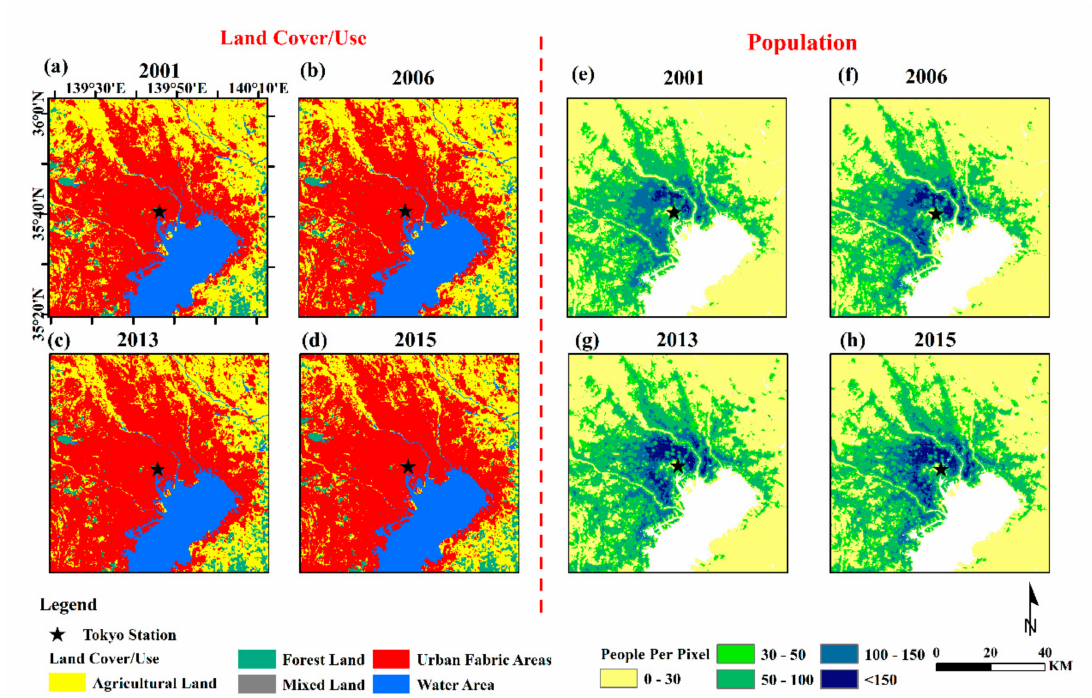
Figure 3. Spatiotemporal evolution of urban development in TMA from 2001–2015: ( a – d ) spatiotemporal patterns of land cover/use, and ( e – h ) spatiotemporal population patterns.